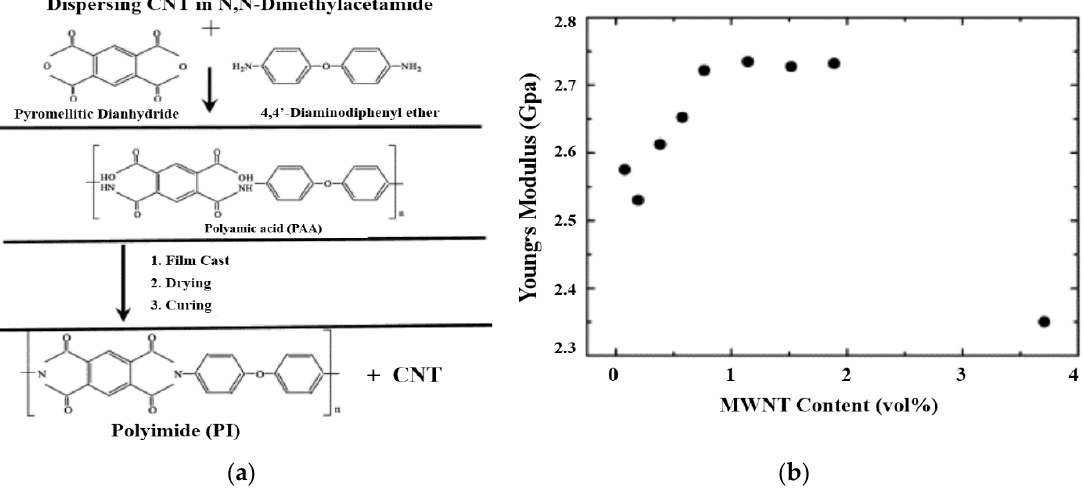
Figure 15. The preparation procedure of polyimide composite film with MWNT carbon ( a ), and Young’s modulus of PI-MWNT composites films against the MWNT content ( b ) [48].